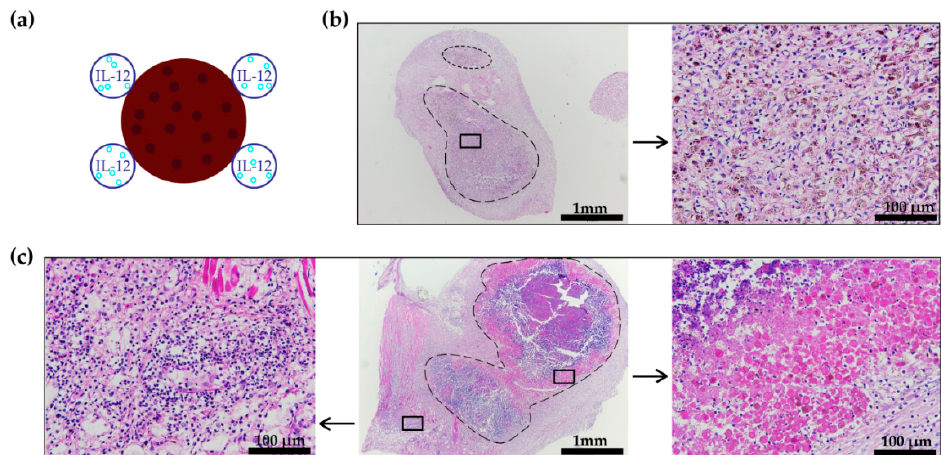
Figure 3. Pilot B16 ‐ F10 vaccination histology. ( a ) Schematic presentation of the vaccine application and IL ‐ 12 GET. ( b , c ) H&E stained histological section of the skin at the location of the pilot vaccine injection and IL ‐ 12 GET. The dashed outline marks the area of the injected pilot vaccine. The squares mark further magnified areas. ( b ) The magnified image shows viable cells at the location of the injected NTC. ( c ) The right magnified image indicates a lower immune cell infiltration to the location of the injected NTC than to the site where IL ‐ 12 GET was performed, as shown on the left magnified image. H&E = hematoxylin and eosin staining. GET = gene electrotransfer; NTC = 1 unit of non ‐ viable B16 ‐ F10 tumor cells (0.5 mg).